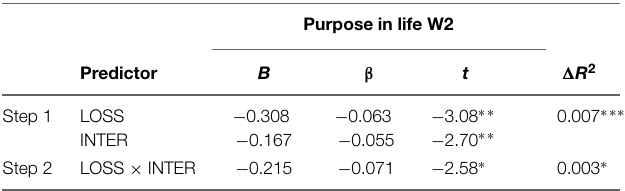
TABLE 1 | Cross-sectional